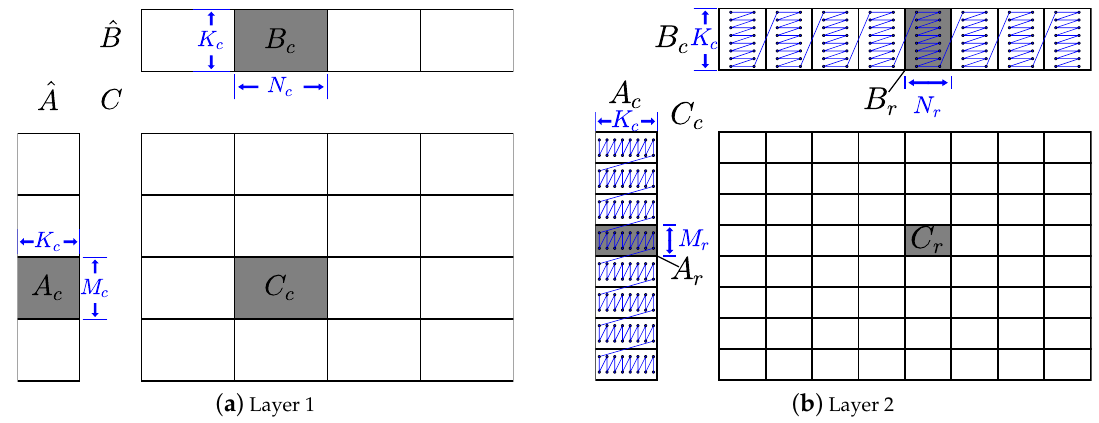
Figure 1. GEMM blocked algorithm. ( a ) The first blocking layer. ( b ) The second blocking layer. The first blocking layer represents a coarse-grained workload partition and the second blocking layer represents a fine-grained one. The memory footprints of tasks on layer 1 and 2 are roughly the same as the size of L2 and L1 caches, respectively. GEMM is a computational intensive operation and